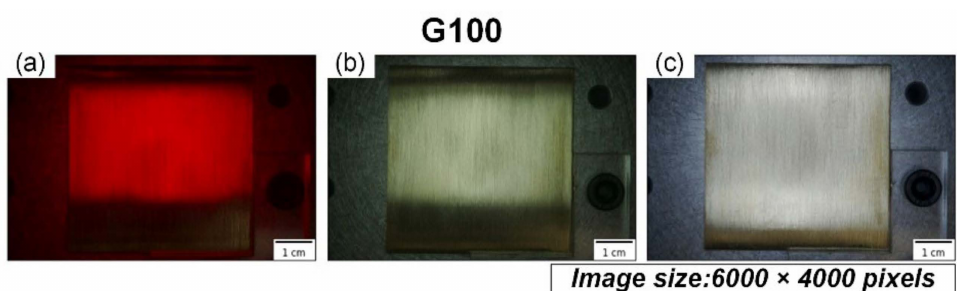
Figure 3. The raw images of the same workpiece illuminated by three different light sources: ( a ) external coaxial red light; ( b ) external coaxial white light; ( c ) high-angle ring white